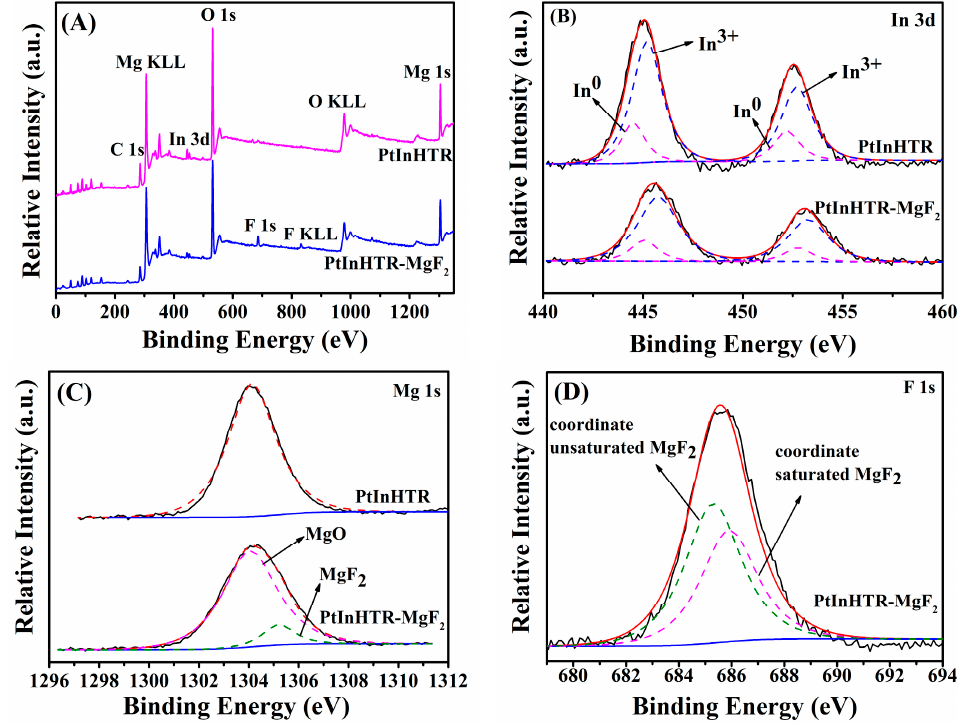
Figure 5. X-ray photoelectron spectroscopy (XPS) spectrum of ( A ) the whole survey, ( B ) In 3d, ( C ) Mg 1s, and ( D ) F 1s for the reduced catalysts. Table 1. XPS results of the In 3d regions for the reduced catalysts.